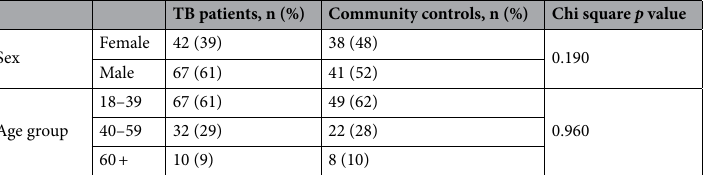
TB patients, n (%) Community controls, n (%) Chi square p